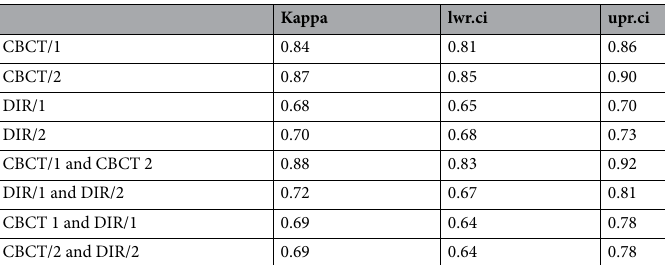
Table 4. Inter-rater reliability for the digital volume tomography (CBCT) and intraoral images (DIR) of the first (1) and second (2) observation trials of the16 observers pooled (kappa = Kappa coefficient; lwr.ci and upr. ci = lower and upper bound of the 95% confidence interval,